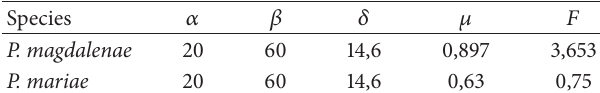
Table 1: Values of the parameters used in the numerical analysis. The values of 𝜇 and 𝐹 correspond to real statistics data on two fish species, P. magdalenae and P. mariae (see [14]). The values 𝛼 , 𝛽 , and 𝛿 have been estimated theoretically due to the lack of real data on them for these species (see Ladino and Valverde